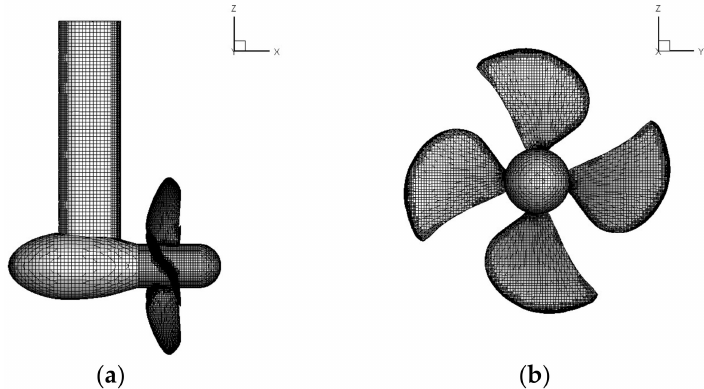
Figure 7. Surface grid: ( a ) Pod unit surface grid ( b ) Blade surface